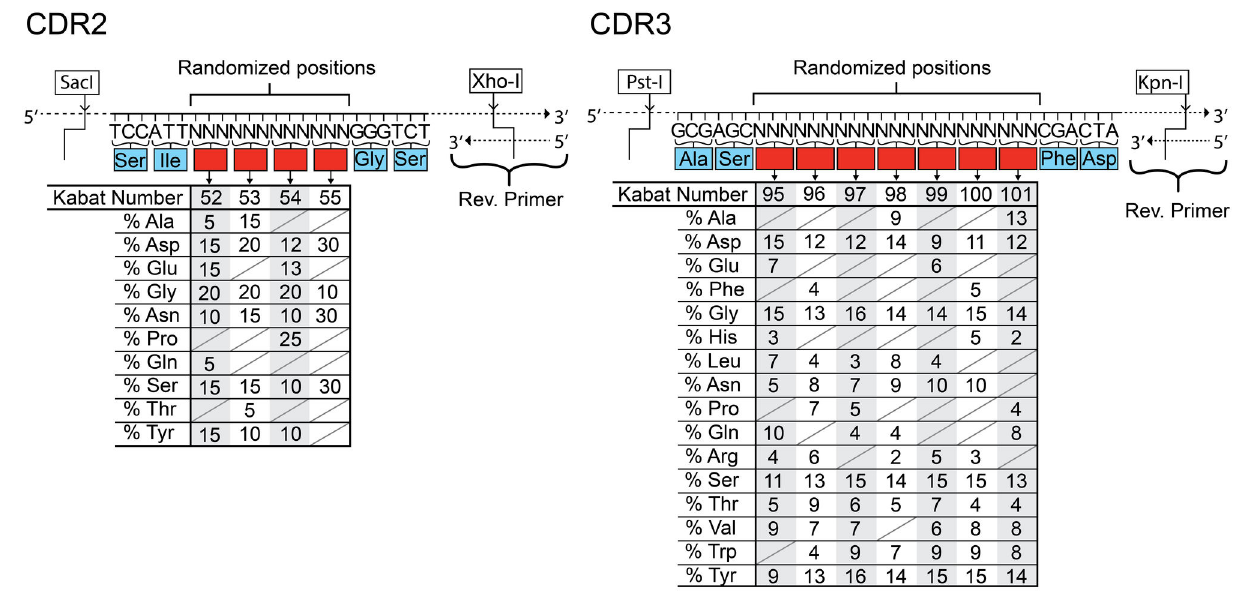
Figure 3. The diversity of the Predator library. The CDR2 and CDR3 of the library have been designed with specific frequencies designated to every amino acid used for all the randomized position (red boxes) in both CDR2 and CDR3 according to the different properties of the amino acids. The frequency of a given amino acid at a given position can be read from the table. The unique restriction sites used for cloning the CDR regions into the vector are shown flanking the